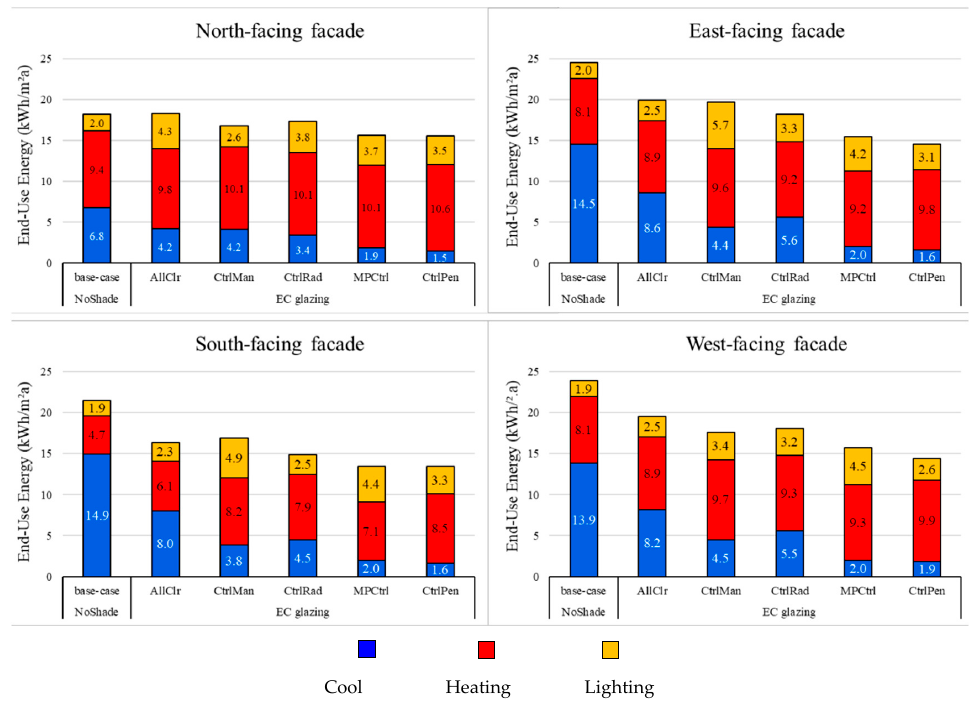
Figure 7. The annual end-use energy of the office room with EC glazing system for different orientations (set point temp. 20–27 °C).